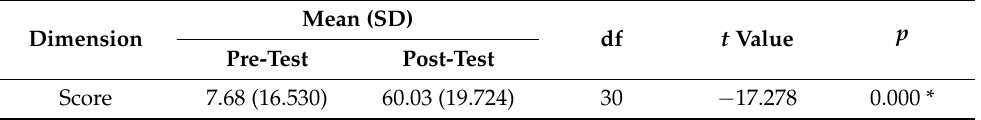
Table 1. Paired samples t -test ( n =